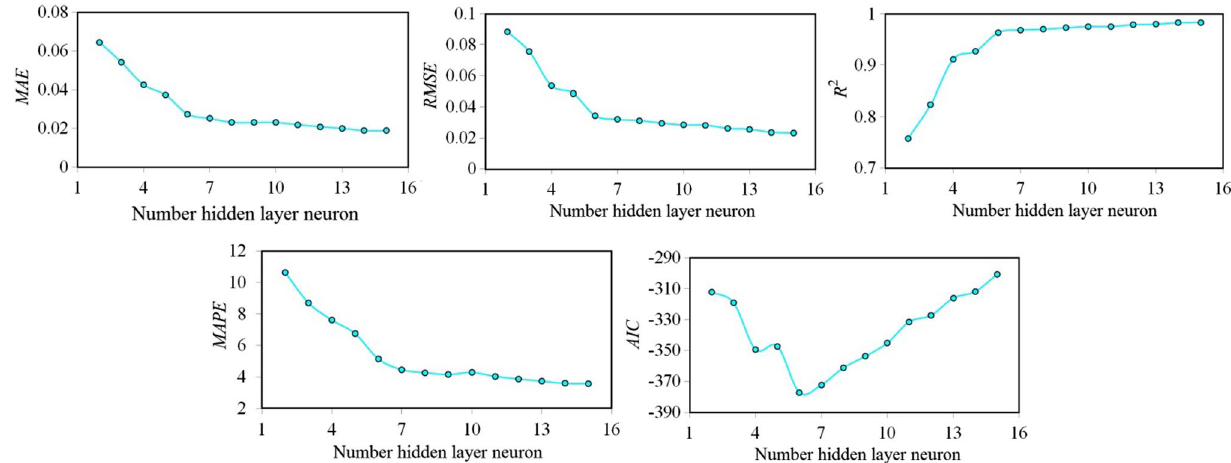
Fig. 4 Changes of different statistical indices versus changes of number of hidden layer neurons